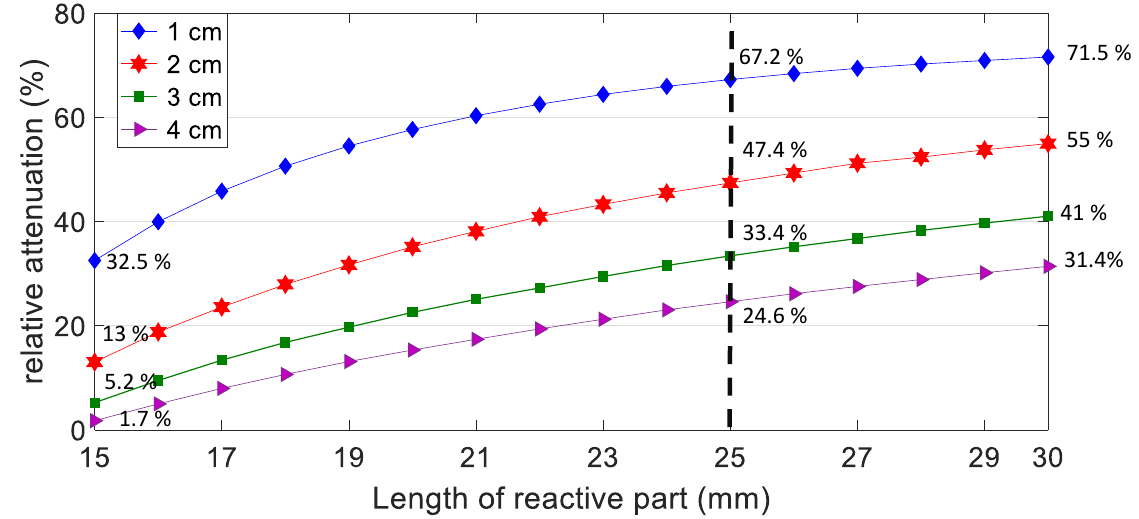
Figure 9. Configuration 1: relative MO attenuation percentage vs. the increase in reactive part length, with a constant thickness value = 1 mm, as derived for four distinct distances between tool and external